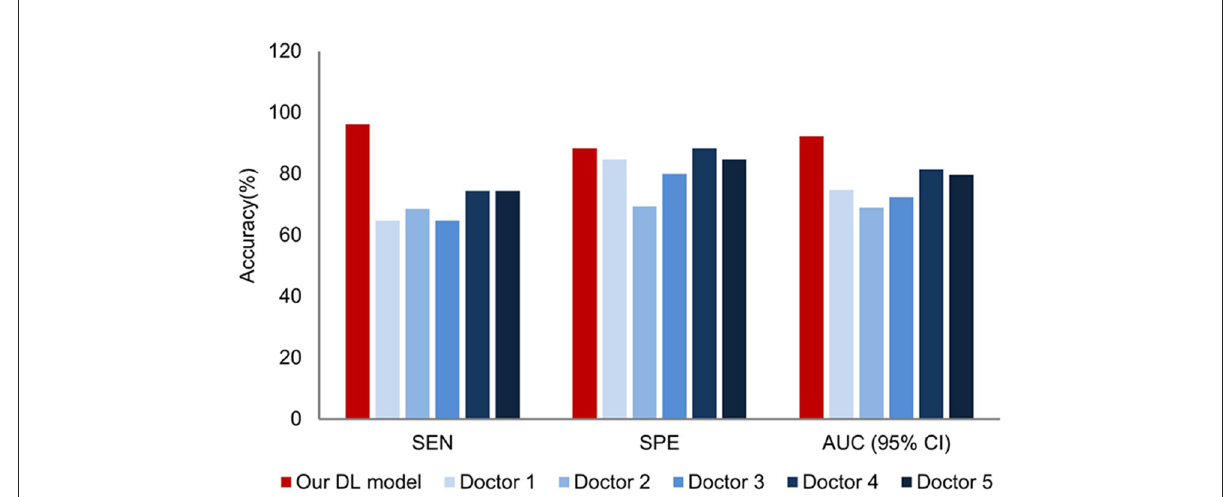
FIGURE5 Comparison of the DL model and dermatologist in the testing dataset.